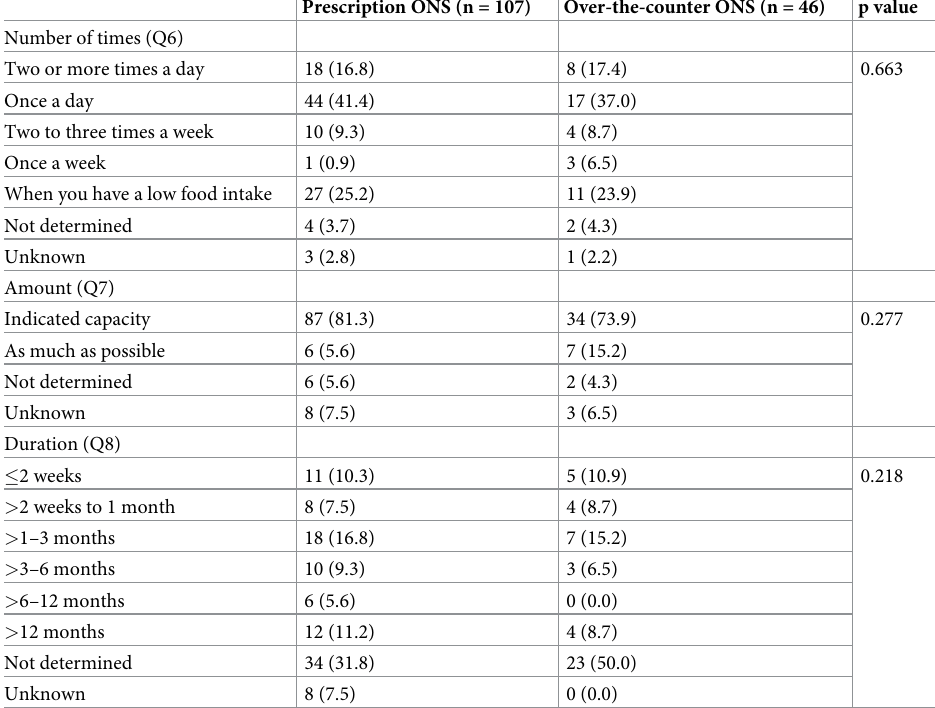
Table 7. Medical advice for